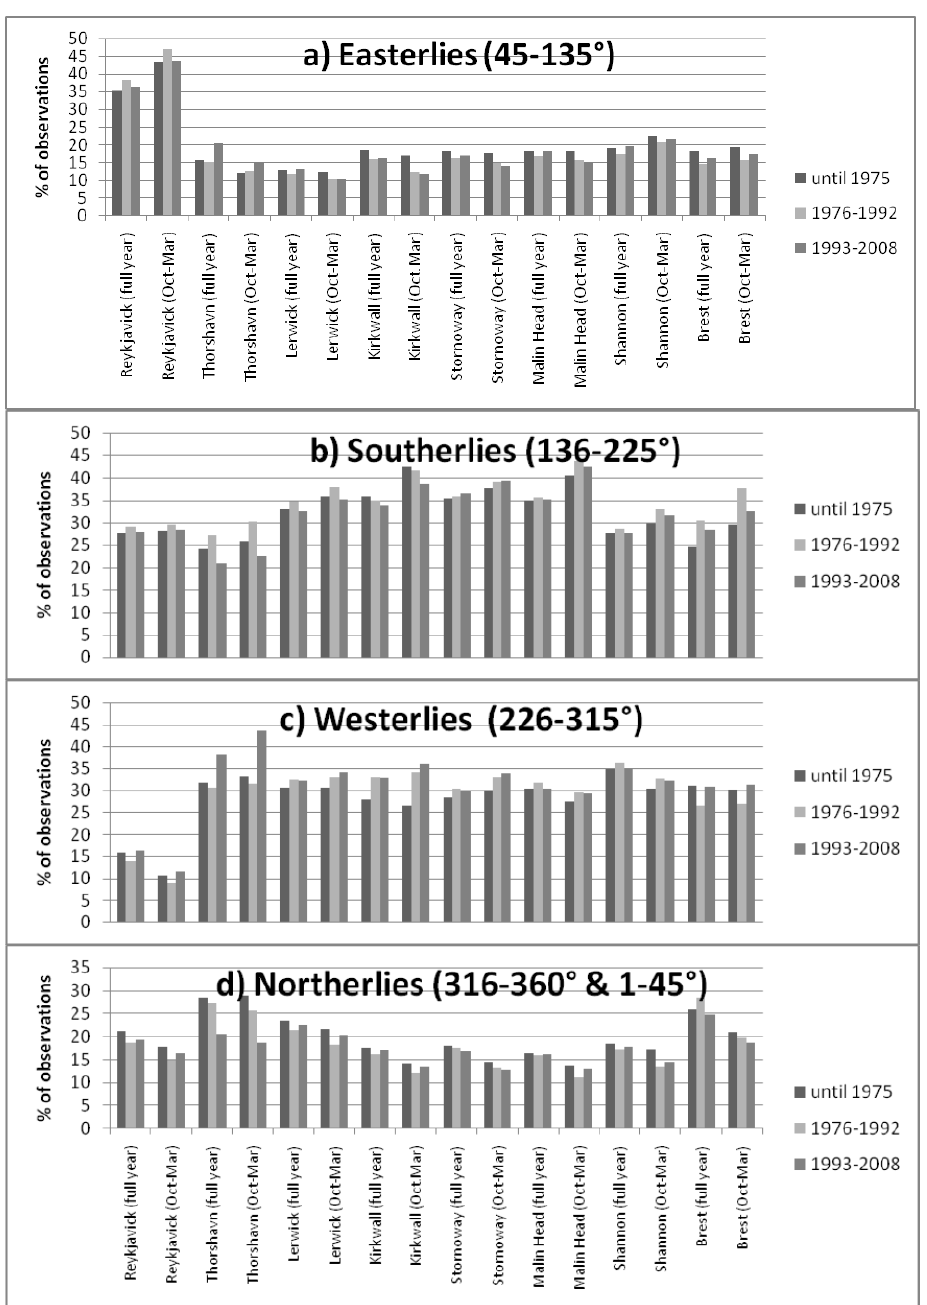
Fig. 5. Frequency of wind measurement in different periods (full year and October to March) at Reykjavick, Thorshavn, Lerwick, Kirkwall, Stornoway, Malin Head, Shannon and Brest. (a) easterlies, (b) southerlies, (c) westerlies, (d)